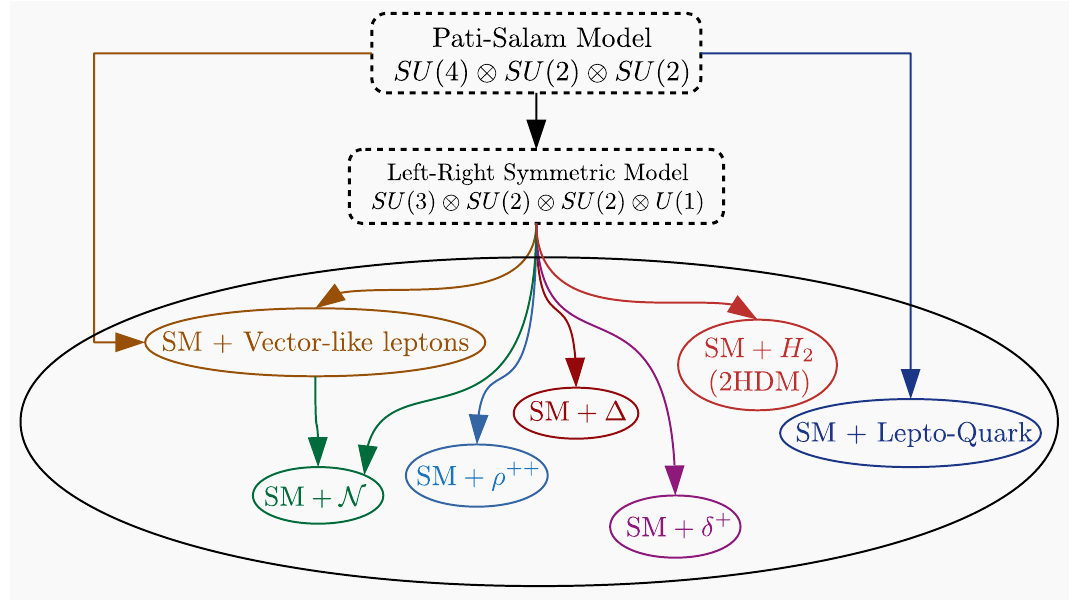
Figure 2 . An elucidation of the inter-connectedness of several BSM scenarios: paving the path to